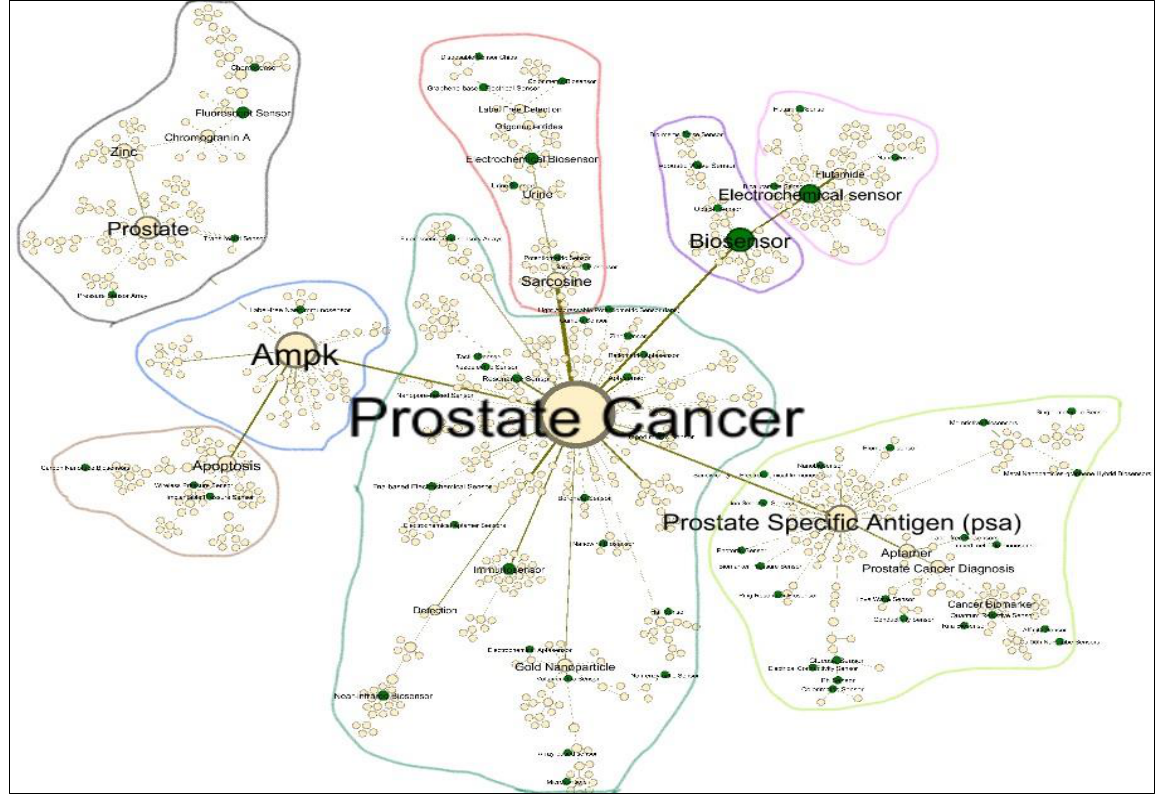
Figure 4. Co-word analysis map of Prostate